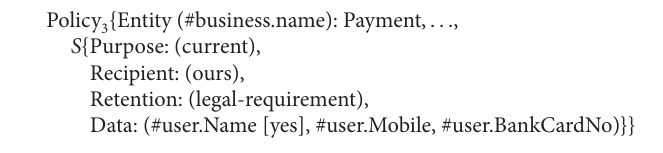
Algorithm 9: P3P policies of FlightBooking service, HotelReservation service, and Payment service (P3P policy of Payment service).